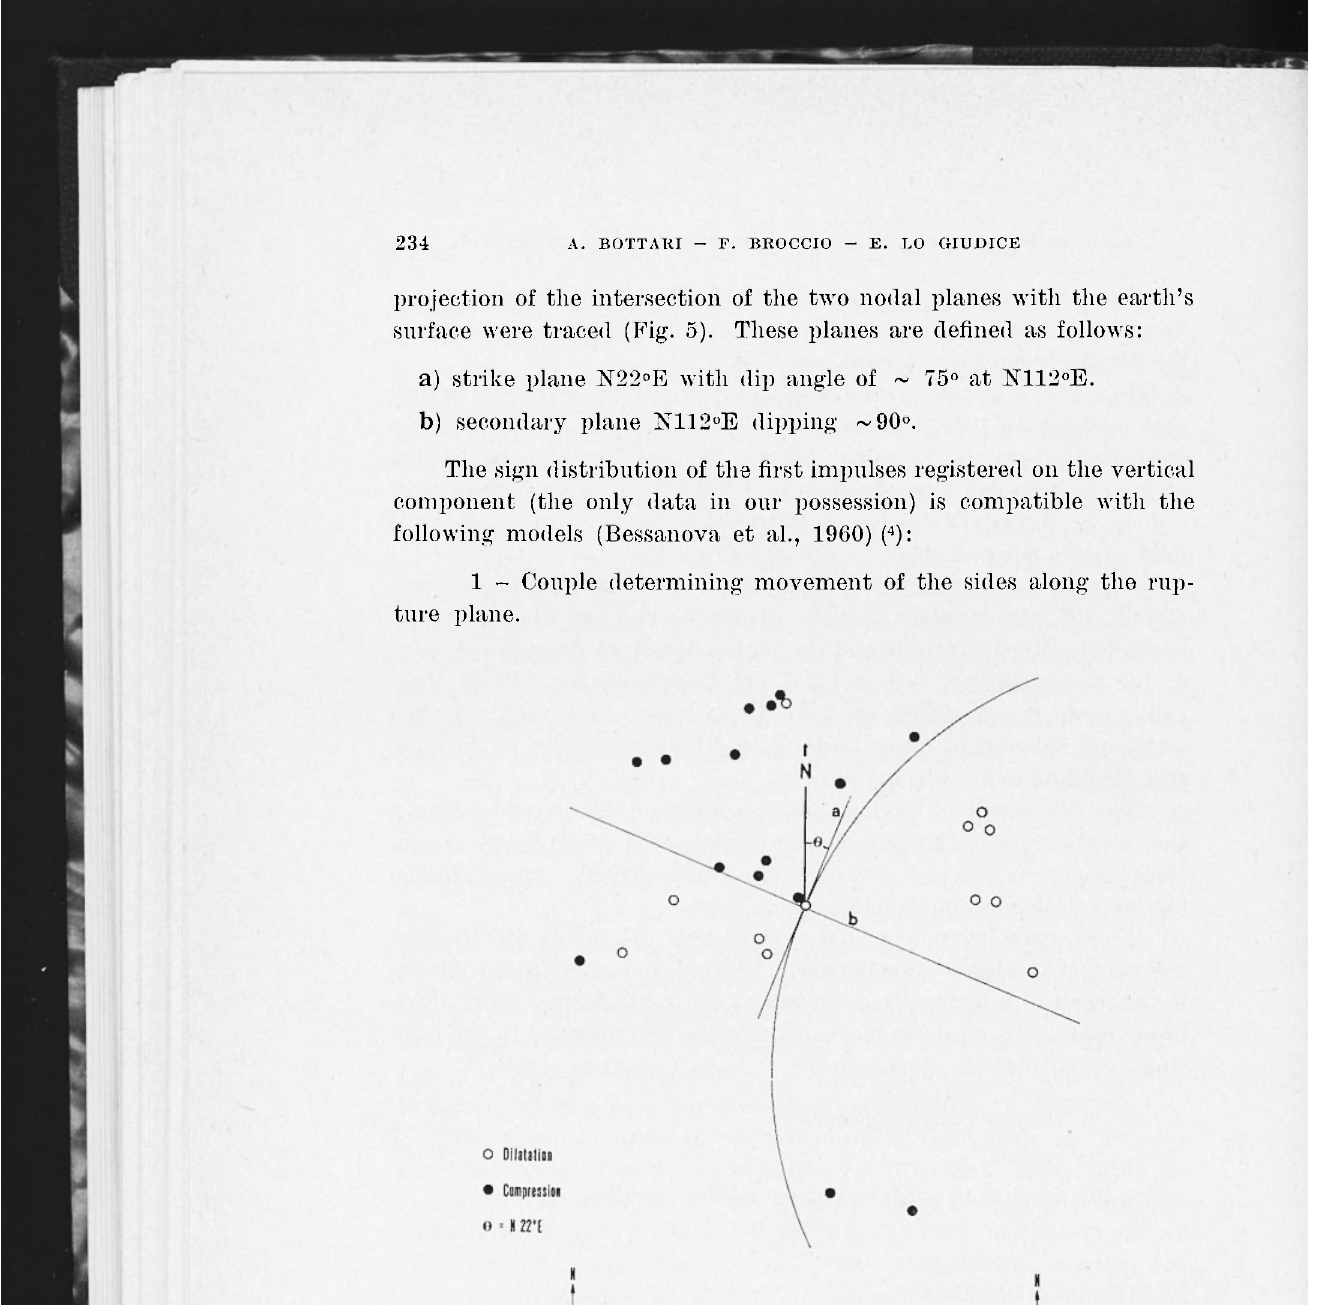
Fig. 5 - Graphical distribution of the first motion signs together with some elements of earthquake mechanism, "a" and "b" indicate the nodal